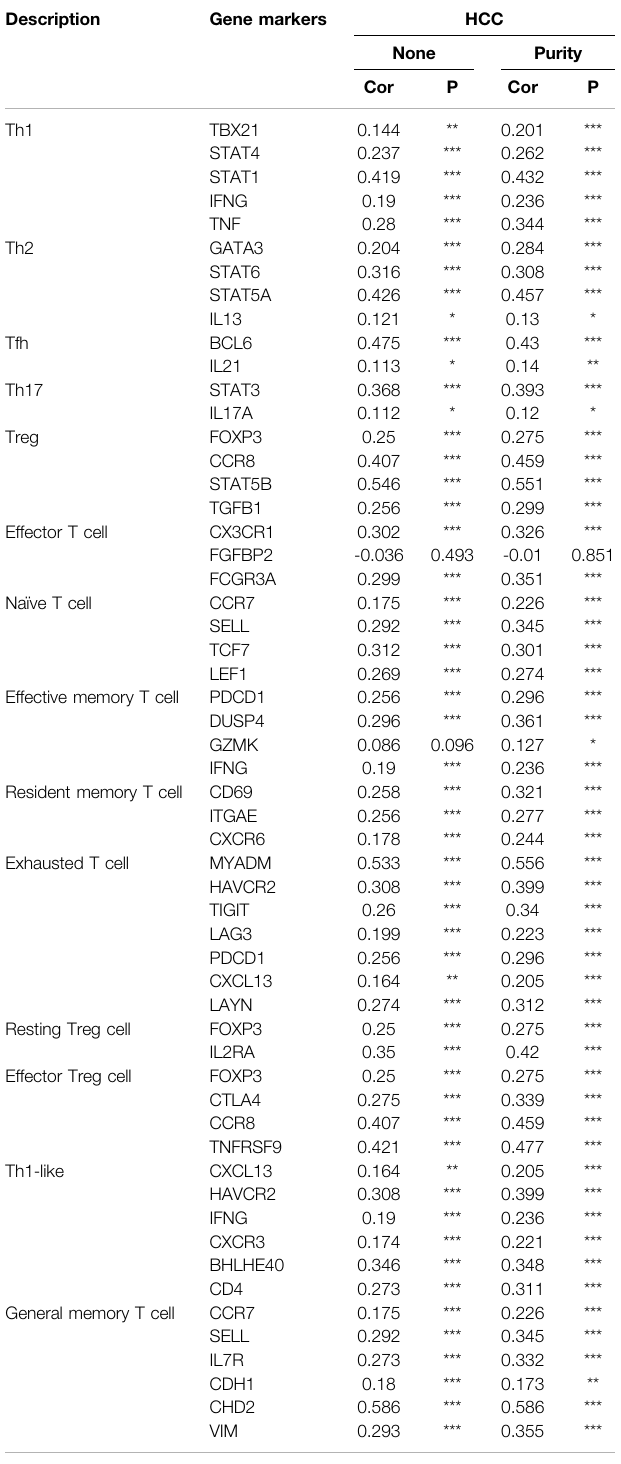
TABLE 3 | Correlation analysis between HSF2 expression and gene markers of different types of T cells using TIMER.